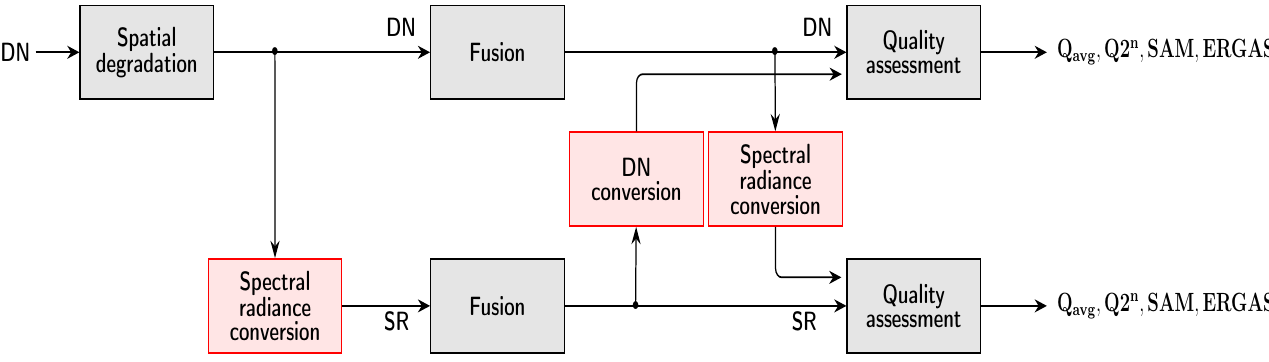
Figure 4. Flowchart of fusion and assessment procedure for spectral radiance data in packed DN and floating-point